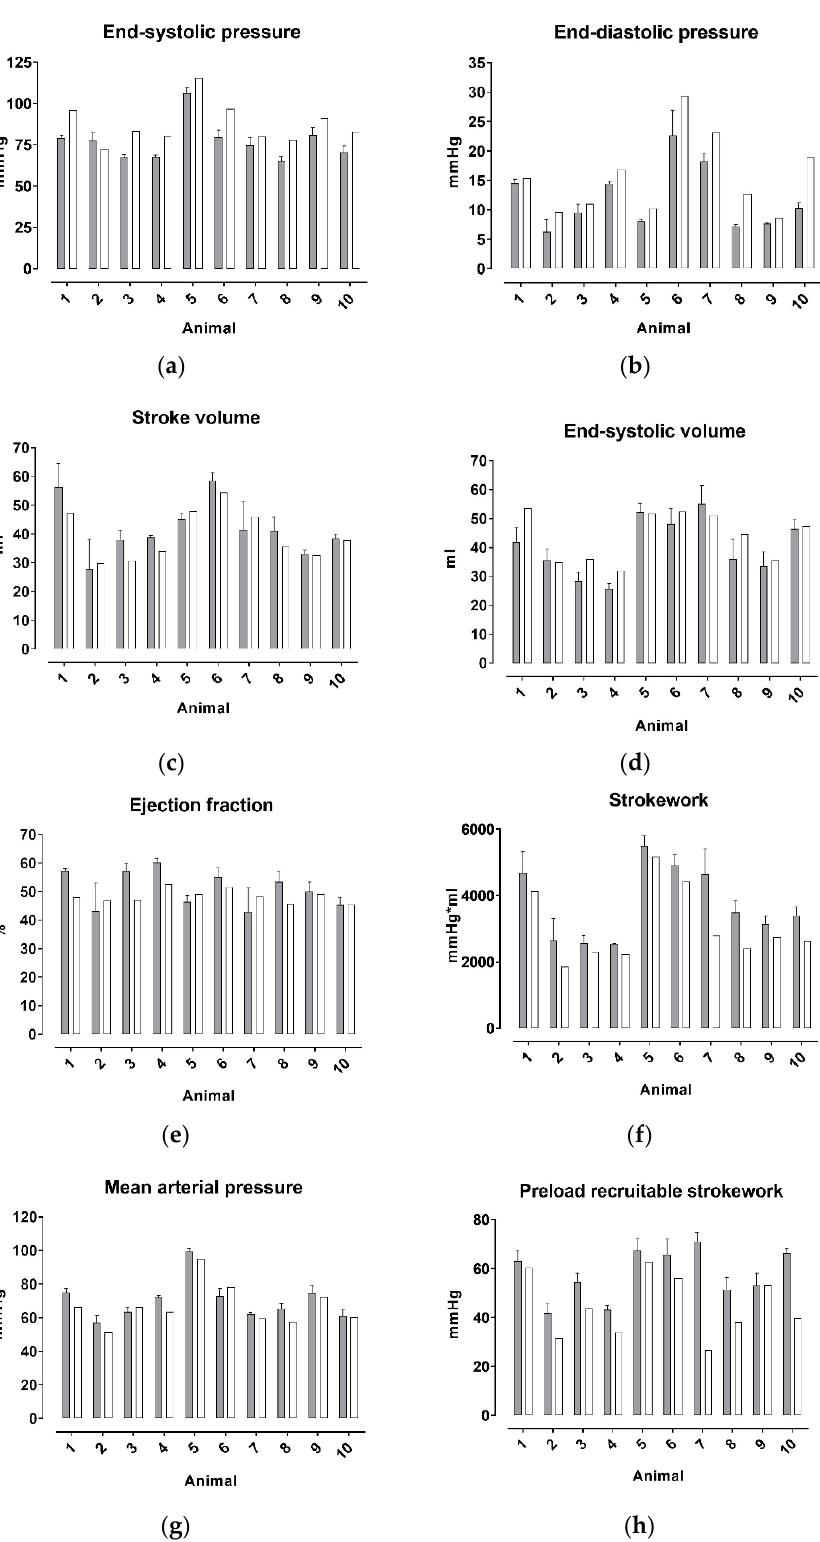
Figure 5. Comparison of animals and simulation. Comparison between the results for the output parameters of animal study (grey) and computer simulation (white) (mean ± SD) of selected haemodynamic parameters: end-systolic pressure ( a ), end-diastolic pressure ( b ), stroke volume ( c ), end-systolic volume ( d ), ejection fraction ( e ), stroke work ( f ), mean arterial pressure ( g ) and preload recruitable stroke work ( h ).